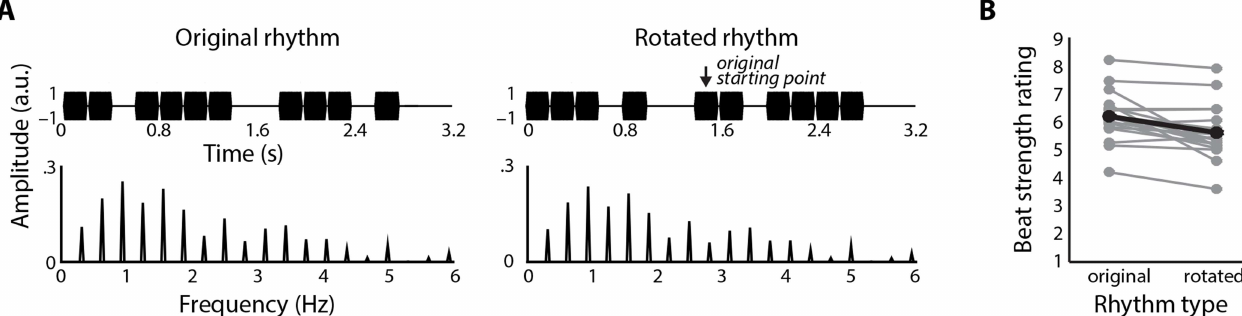
Fig 5. Beat perception differs for rhythms with identical frequency-domain representations. A. By rotatingsimplerhythms (i.e., playingthem starting from a different point in the sequence), we createdtwo version of rhythms with numerically identicalfrequency-domainrepresentations. B. Beat strength ratingsdifferedsignificantlybetweenoriginalandrotated rhythms. Individualparticipant data are shown in gray, andmean data are overlaidin